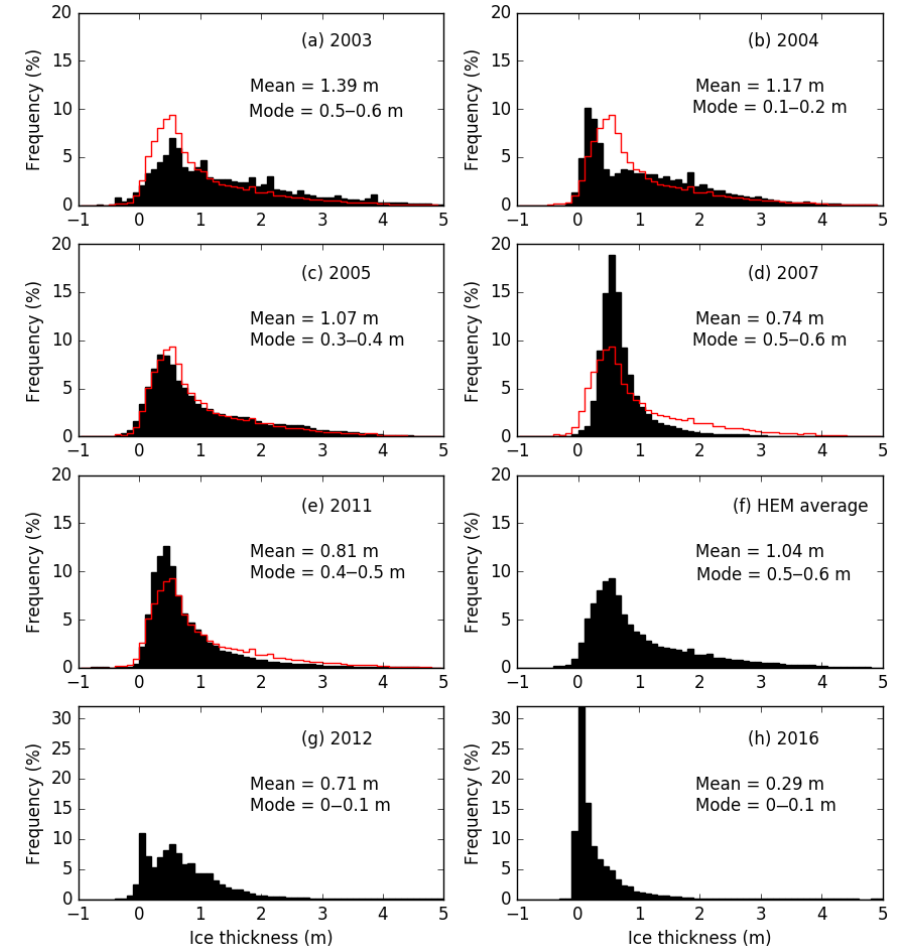
Figure 10. Frequency histograms of helicopter EM ice thickness in the drift ice area west of Hailuoto for (a) 2003, (b) 2004, (c) 2005, (d) 2007, and (e) 2011 (in black). The average of all years of HEM is in panel (f) and in red in other panels. Frequency histograms of ship EM ice thickness in the drift ice area west of Hailuoto (g) 2012 and (h) 2016. To avoid areal focus we have first calculated histograms in a 1 × 1 NM 2 grid for each grid point and then averaged all histograms from the grid points.